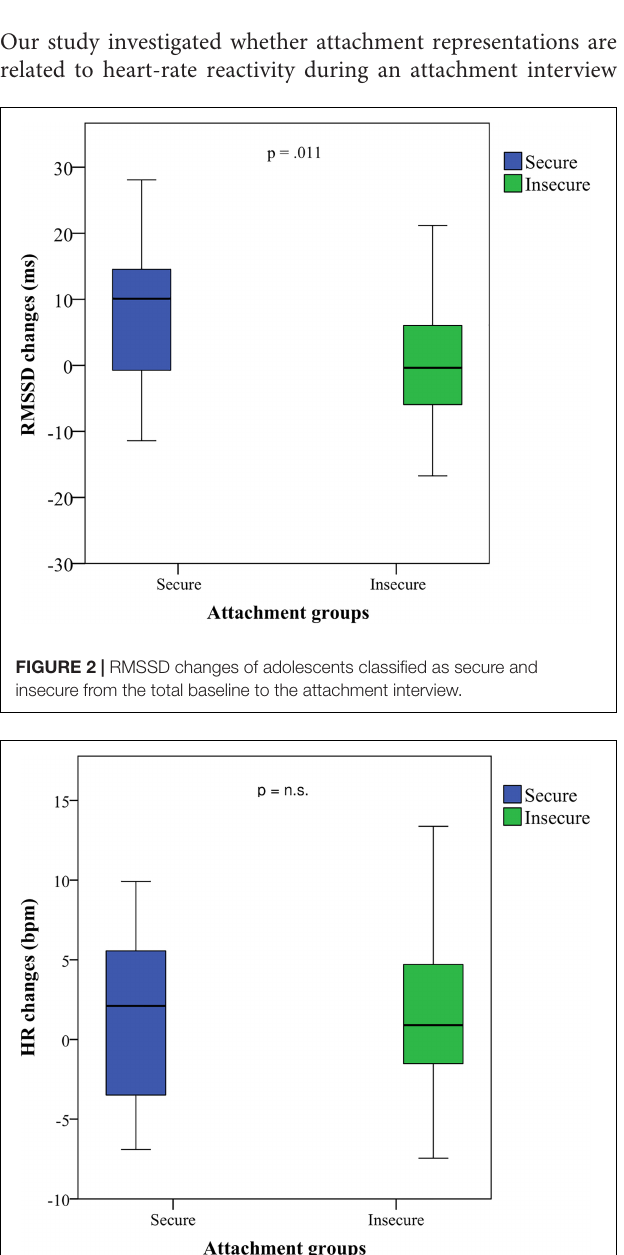
FIGURE 3 | HR changes of adolescents classified as secure and insecure from the total baseline to the attachment